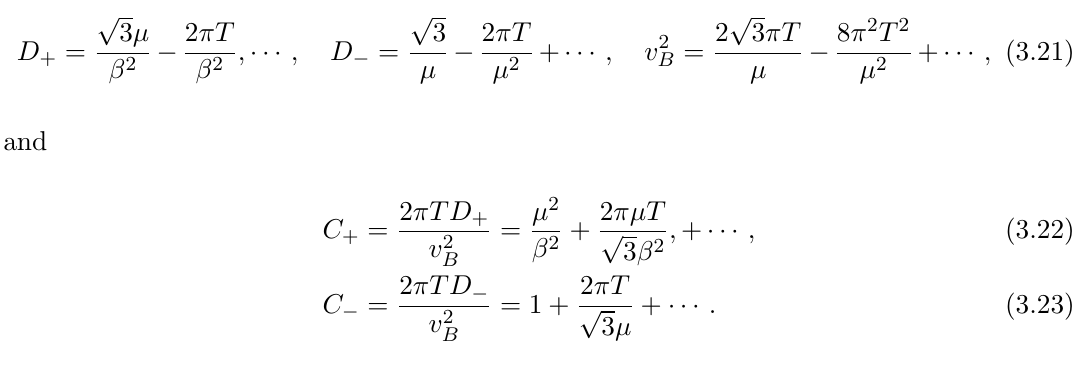
Figure 2 . Di(cid:11)usion constants of the linear axion model with/without a mixing term. (cid:22)=T = 0 : 1 ; 1 ; 5 from left to right. The blue curve is for D c and the red curve is for D e . The triangles display the results without the mixing term M in (3.14). For comparison, we also display the results with the mixing term, the solid curves in (cid:12)gure